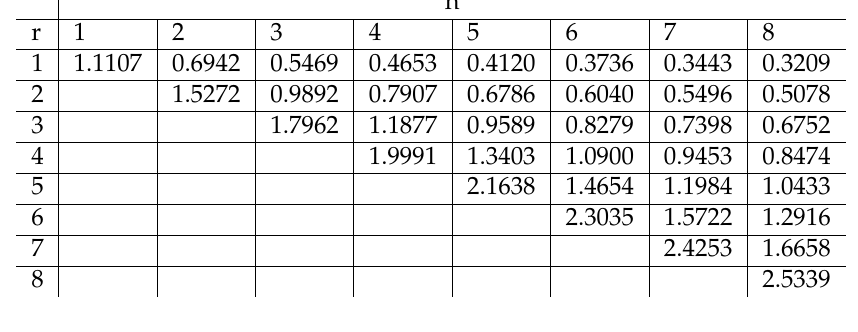
Table 2. Variances of order statistics from Pareto-Rayleigh distribution( α =2, σ =1)